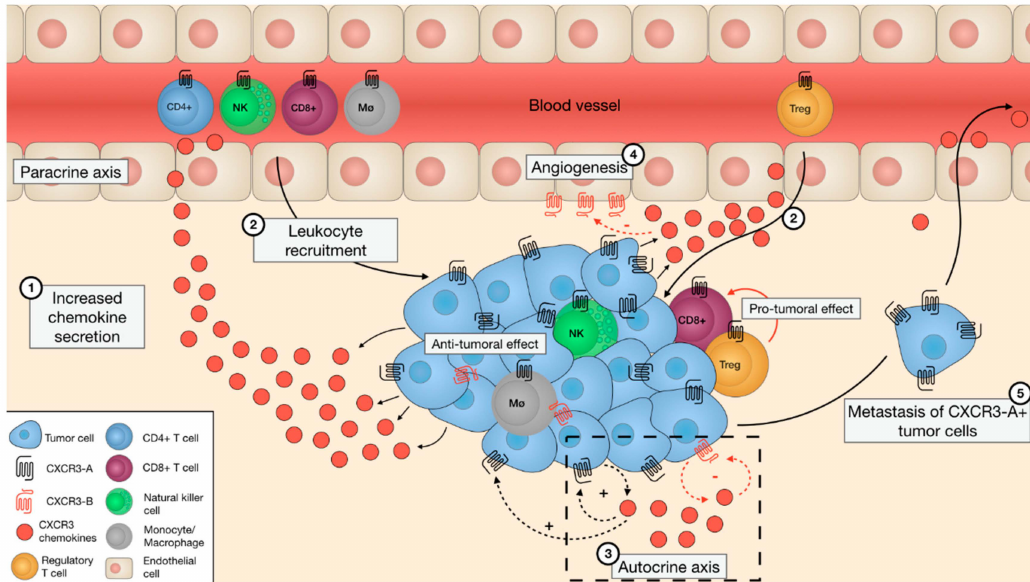
Figure 2. Illustration of the roles of CXCR3 variants and their ligands in the tumor microenvironment. The increased secretion of CXCR3 ligands in the TME, originating from the tumor cells, results in an increased chemokine gradient (1) and the recruitment of CXCR3-A + leukocytes towards the tumor (paracrine axis) (2). The Th1-related immune cells drive anti-tumoral responses, while the recruited CXCR3-A + Tregs have a pro-tumoral e ff ect by suppressing other immune cells. The secreted chemokines also bind to CXCR3-A or CXCR3-B, present on secreting (autocrine axis) and neighboring tumor cells, and depending on the cellular context, may induce a proliferative or inhibitory e ff ect (3). Moreover, the chemokines in close proximity to the endothelial cells attenuate the angiogenesis by activating CXCR3-B (4). In addition, the increased expression of CXCR3-A, together with decreased CXCR3-B expression, on the tumor cells enable them to detach from the tumor mass and disseminate to a distant tissue